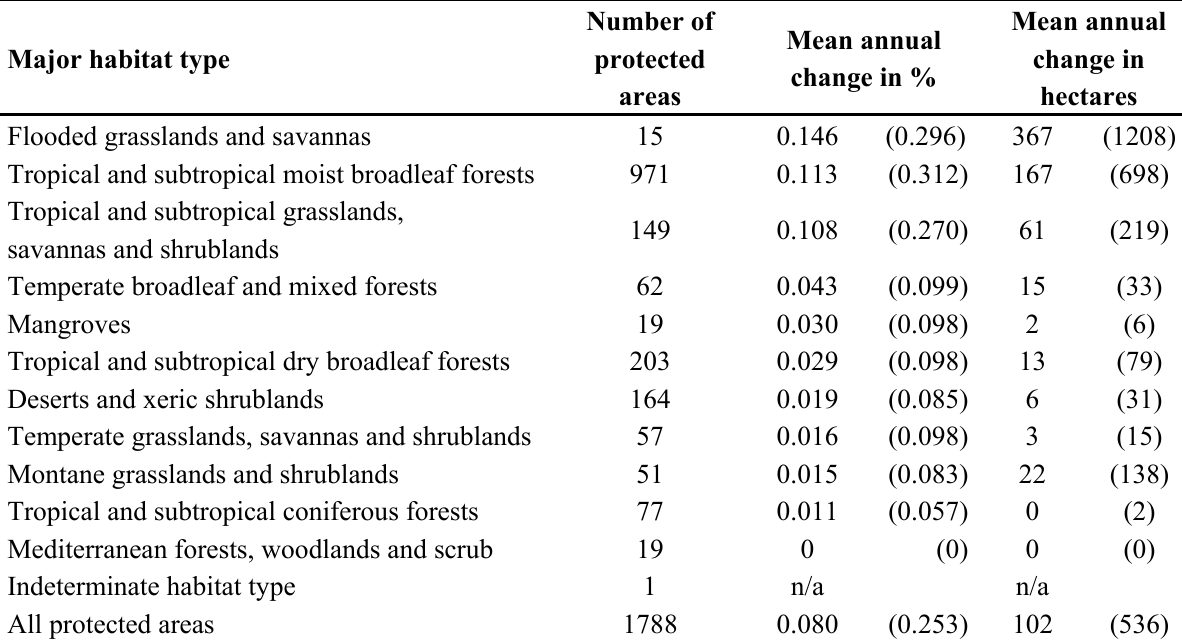
Table 4. 2004–2009 mean annual change in land and forest degradation inside protected areas by major habitat type (standard deviations in parentheses).